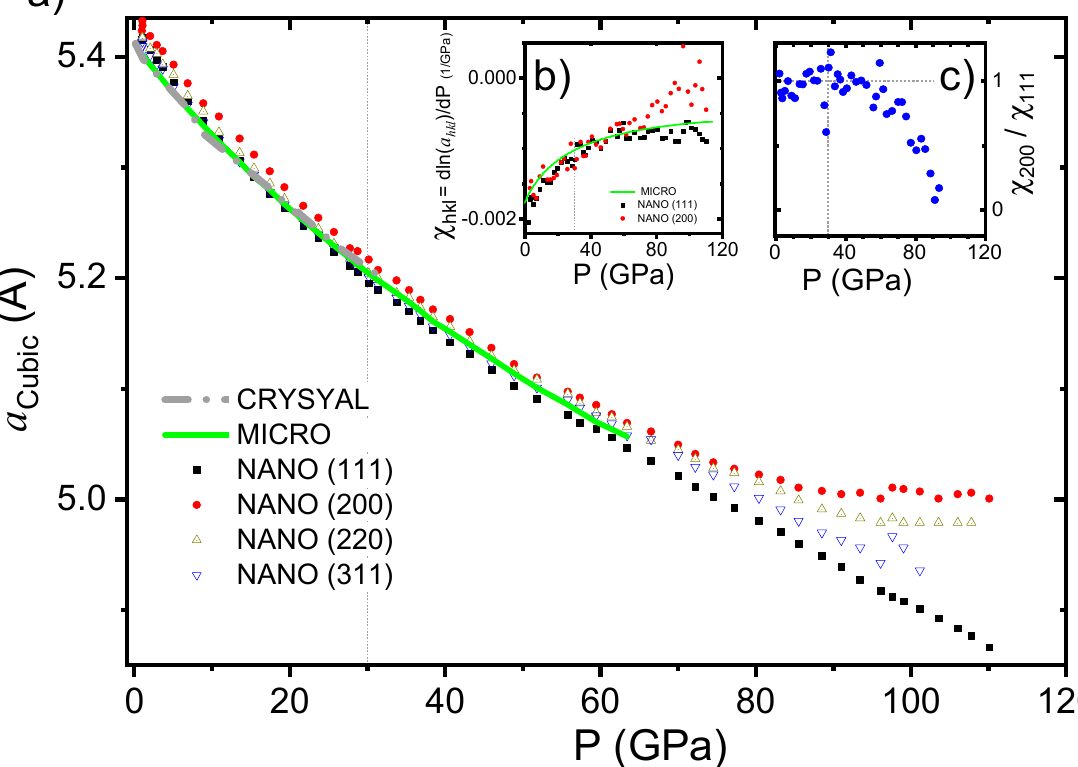
Figure 2. ( a ) Lattice parameters of the cubic structure ( a CUBIC ) for the CRYSTAL, MICRO and NANO samples in the function of pressure. In the case of the NANO sample, the cubic lattice parameter was calculated for each independent reflection ((111), (200), (220) and (311)). ( b ) Pressure dependence of the logarithmic derivative of the lattice parameter respect to the pressure, χ hkl for both the MICRO and NANO samples. ( c ) Pressure dependence of the ratio χ 200 / χ 111 ; a clear deviation from pressure above 50 GPa can be observed.